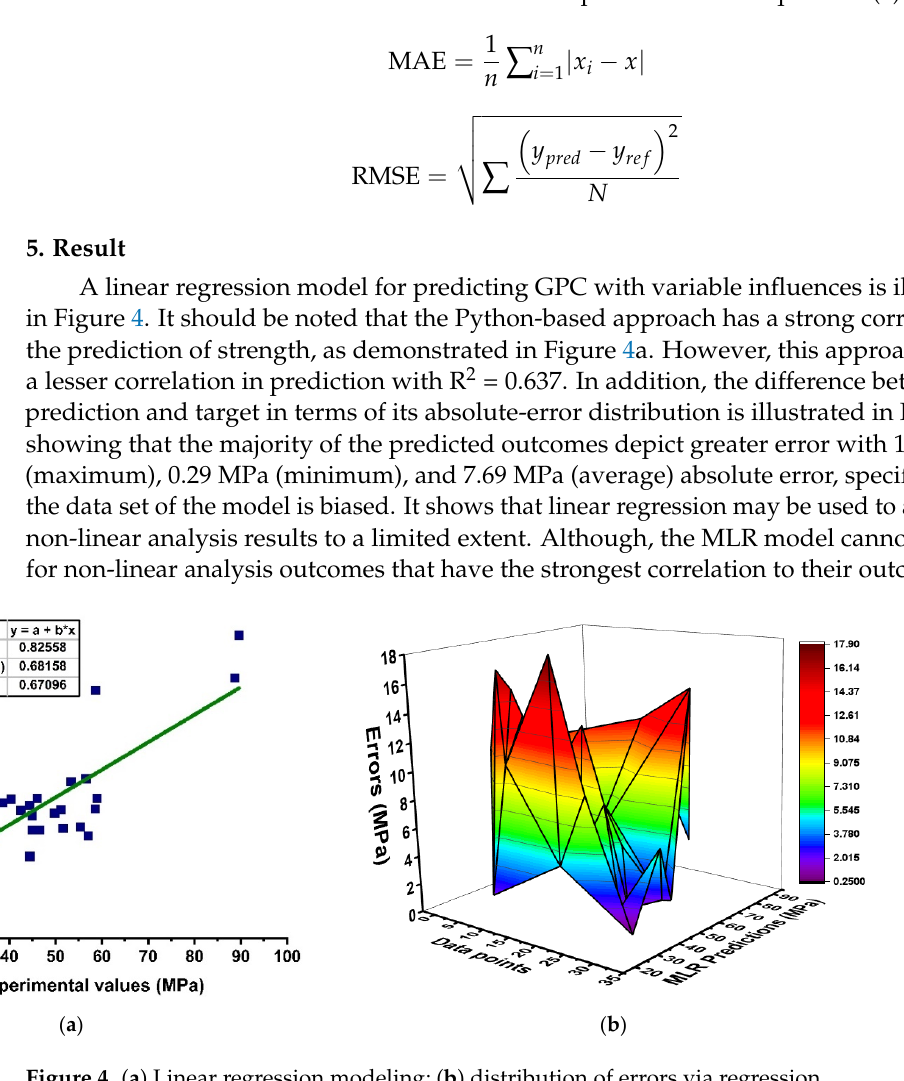
Table 4. N-estimator response of models.